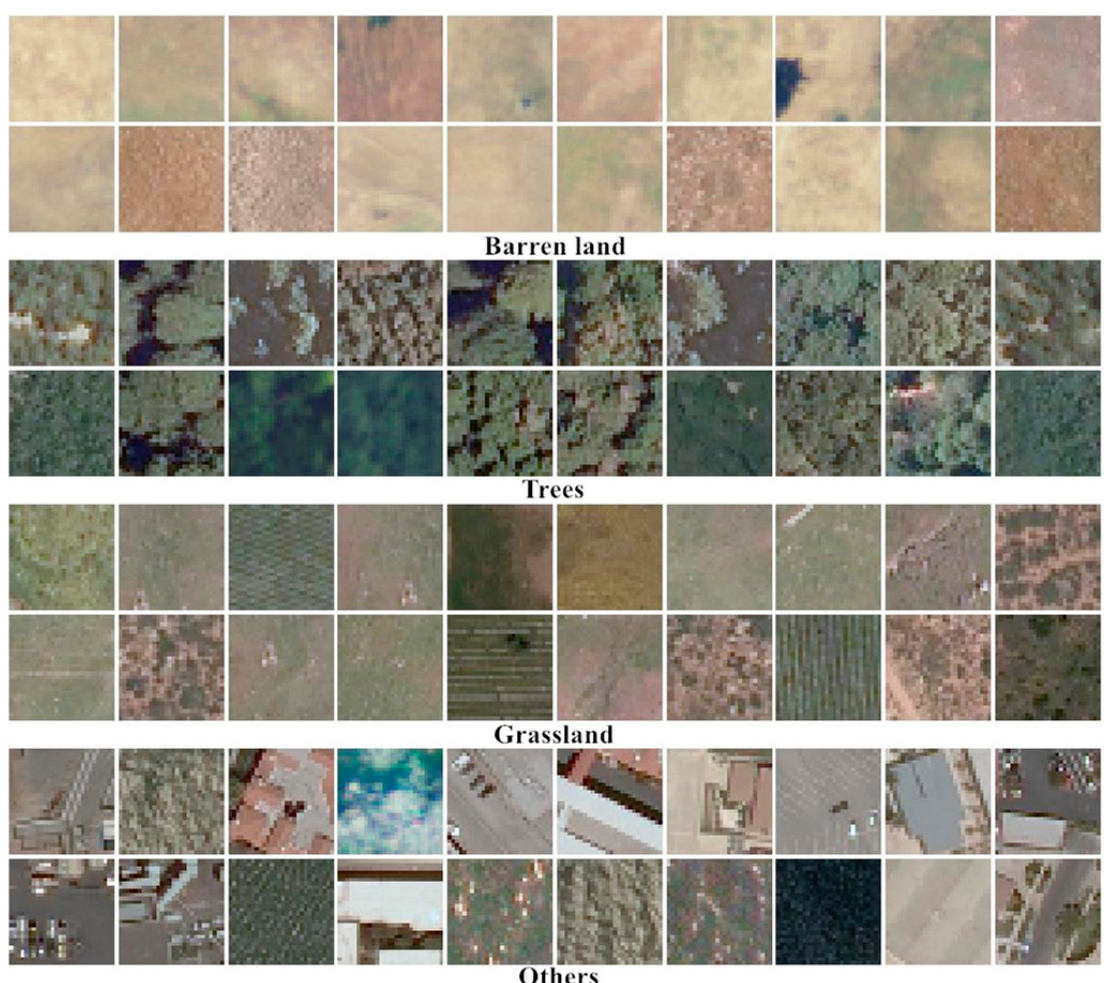
Figure 3. Visual samples of the SAT-4 dataset.